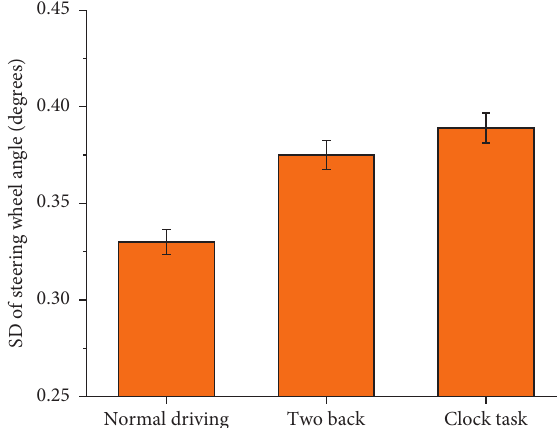
Figure 15: Main effect of the driving tasks on the SDSWA.